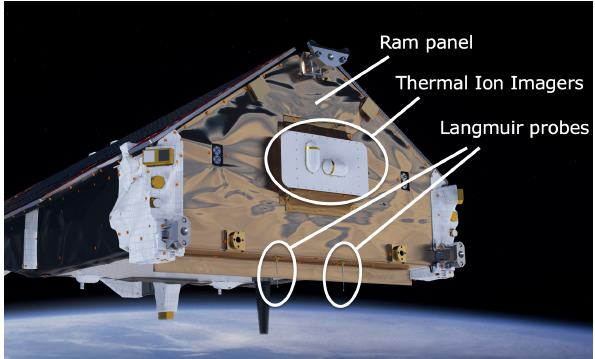
Figure 1. Location of the LPs below the ram panel. Image credits: ESA/ATG medialab.